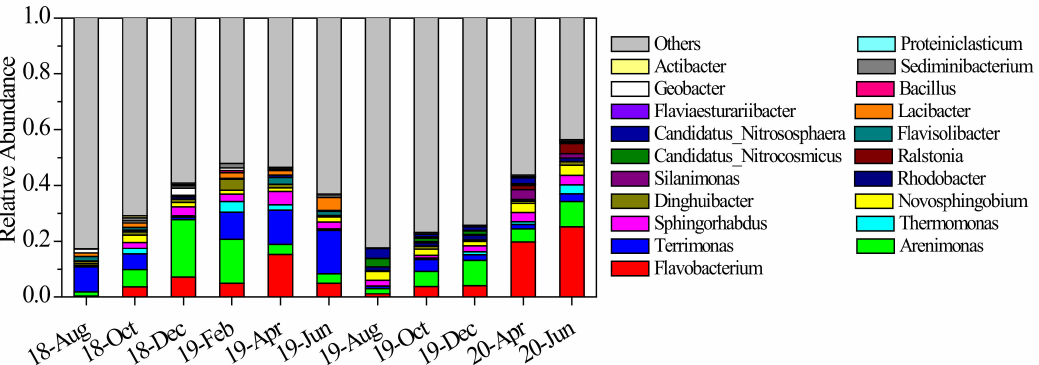
Figure 5. Average abundance proportions of dominant sediment microbial genera from August 2018 to June 2020. Values are expressed as the mean of sampling sites.